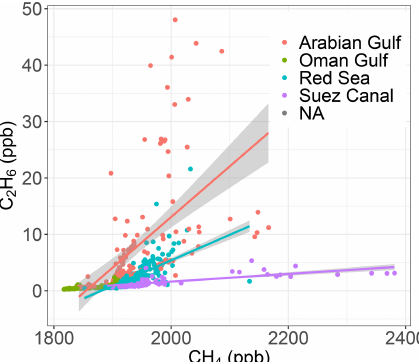
Figure 5. Scatterplot of ethane and methane for the Gulf of Oman, Arabian Gulf, Red Sea and Suez Canal. The regression line and as- sociated 95% confidence interval are plotted for the Arabian Gulf, Red Sea and Suez Canal